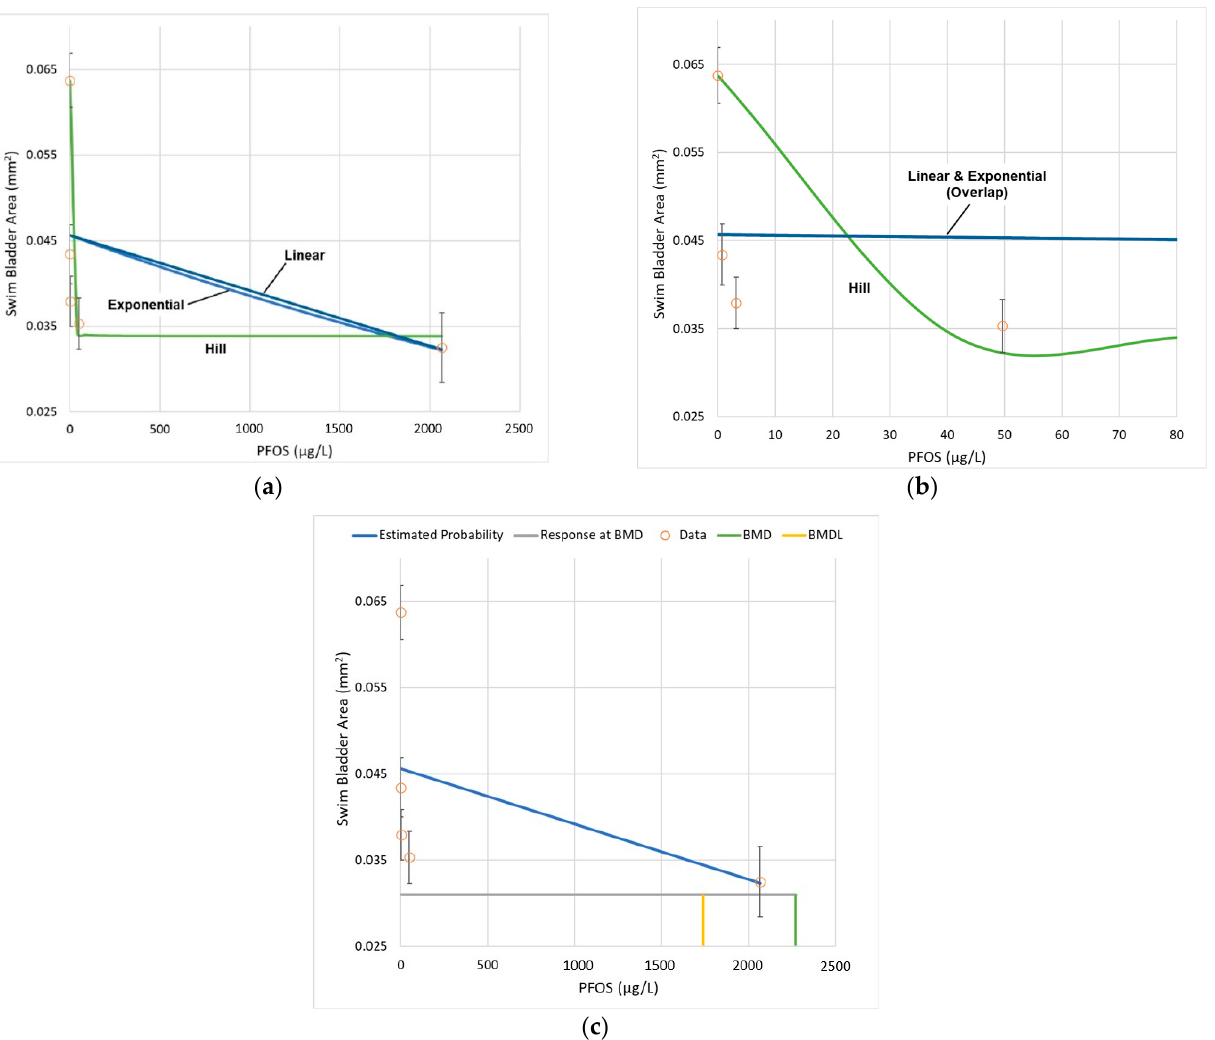
Figure 3. Dose–response curves for PFOS (alone) and SBA (all three replicates combined): ( a ) The uncertainty in the shape of the curve between T3 (50 µg/L) and T4 (2066 µg/L). ( b ) The same as ( a ), but for the dose range <80 µg/L. Each model yields comparable fit statistics using BMDS 3.1.1, as well as estimates of BMD and BMDL (see Table 4) corresponding to a BMR at one control SD. ( c ) Linear D–R model showing the BMD and BMDL for BMR = control + 1 SD.